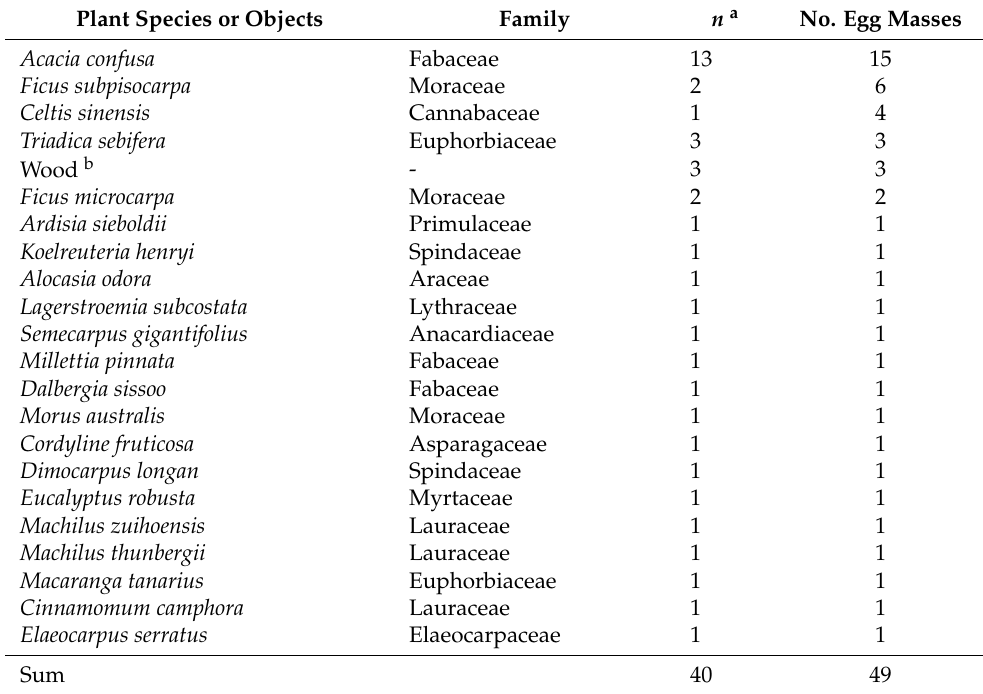
Table 2. Number of egg masses of Pyrops candelaria recorded on different plant species or objects from 30 April–15 July 2021. Plant Species or Objects